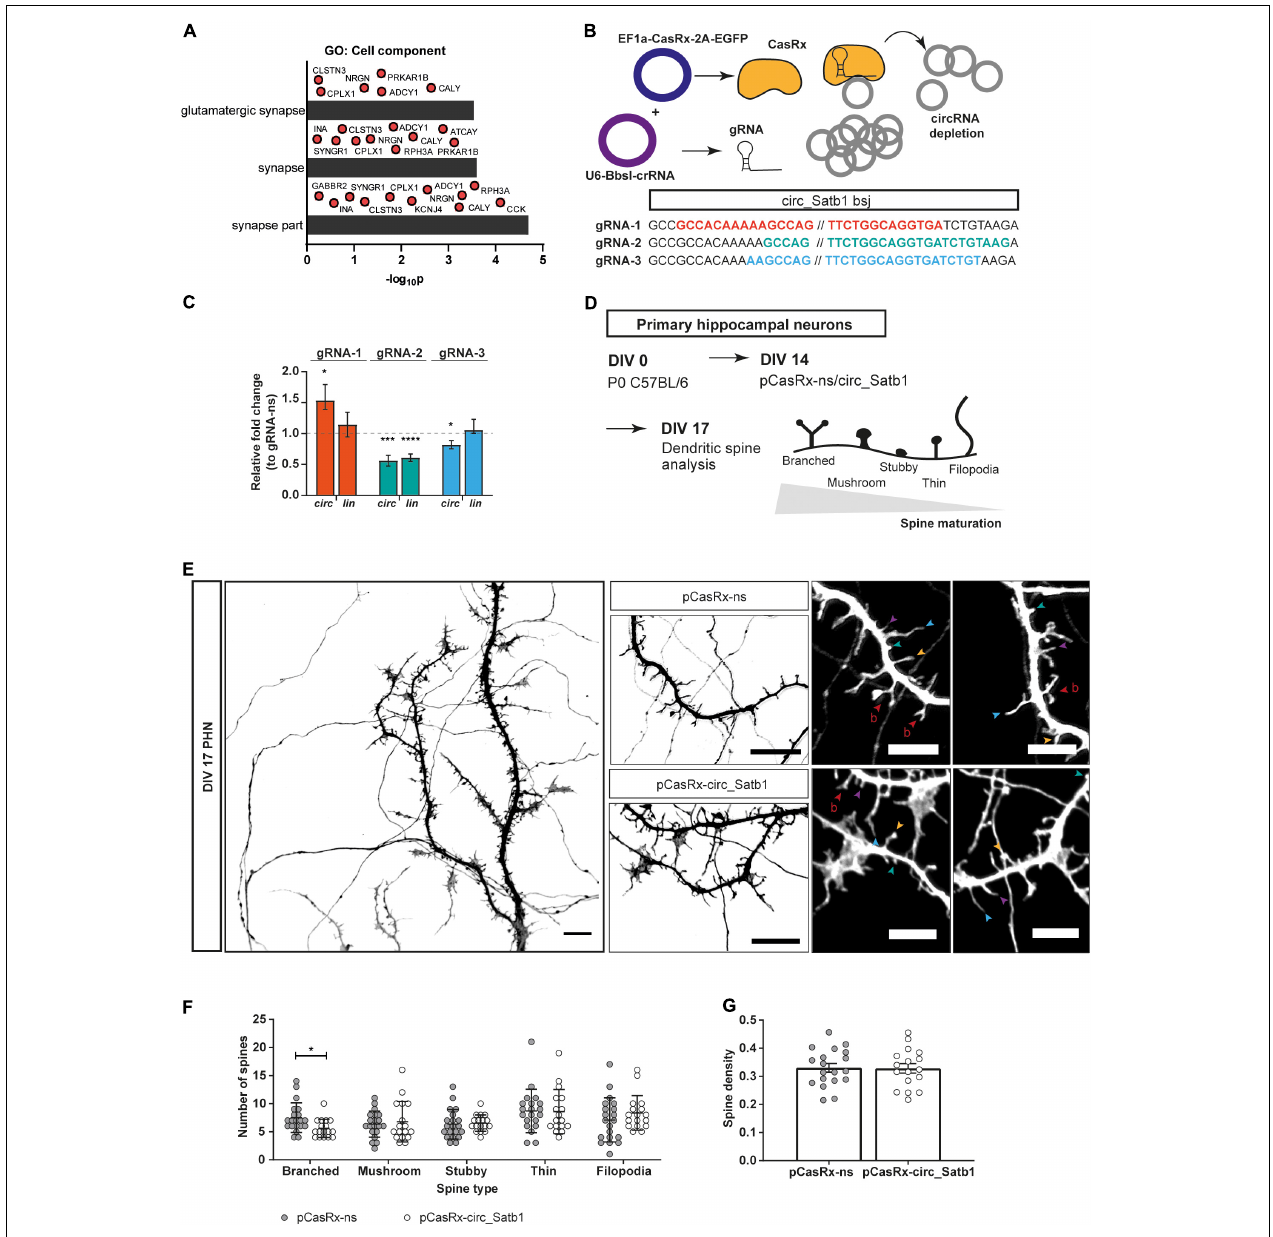
FIGURE 5 | Circ_Satb1 downregulation affects spine morphology. (A) Gene ontology (GO) analysis of circ_Satb1 co-expressed transcripts in mTLE hippocampal samples. GO category “Cell component” is shown ( p < 0.01) ( p , p -value). (B) CasRx-based knockdown system and design. Three guide RNAs (gRNA) targeting different sites across the back-splice junction were designed and cloned into the U6- Bbs I-crRNA vector. (C) Validation of circ_Satb1 knockdown constructs (gRNA-1–3), 48 h post-transfection in Neuro-2a cells. Bar plots show transcript expression normalized to Hprt1 and relative to control condition (gRNA-ns, dotted line) ± SEM; * p = 0.0411, *** p = 0.0009, **** p < 0.0001, * p = 0.0346. Unpaired two-tailed t -test; n = 4–6, 2–3 independent transfections (ns, non-specific; circ, circular; lin , linear; Hprt1, Hypoxanthine Phosphoribosyltransferase 1 ). (D) Workflow schematics of dendritic spine analysis experiments. PHN were cultured and transfected with Cas-Rx knockdown constructs or control vectors at days in vitro (DIV) 14. Neurons were fixed at DIV17 and the dendritic spines were analyzed after image acquisition using confocal microscopy. (E) Representative images of dendritic spines present in pCasRx-ns and pCasRx-circ_Satb1 conditions. Signal shows GFP detection (pCasRx_EGFP) in a single DIV17 neuron at 63 × magnification and selected dendritic regions transfected with different CasRx-constructs. Images were converted to gray scale for improved visualization. Scale bar: 10 µ m. Right side panel shows differences in spine morphology between pCasRx-ns and pCasRx-circ_Satb1 transfected neurons. Arrows indicate different spine morphology types, classified as reported previously (Vangoor et al., 2019): filopodia (blue); thin (purple); stubby (green); mushroom (yellow); and branched (red). Scale bar: 5 µ m. (F) Spine morphology distribution upon circ_Satb1 knockdown in neuronal cultures. Bars represent mean ± SD, * p = 0.0112. Each dot represents a single analyzed neuron. Two-way ANOVA ( F statistic = 4.548; p = 0.0049) with Fisher’s LSD post hoc test ( p < 0.05); n = 3 independent cultures. (G) Quantification of spine density upon circ_Satb1 knockdown in neuronal cultures. Bar plots represent mean ± SEM. Each dot represents a single analyzed neuron. N = 3 independent